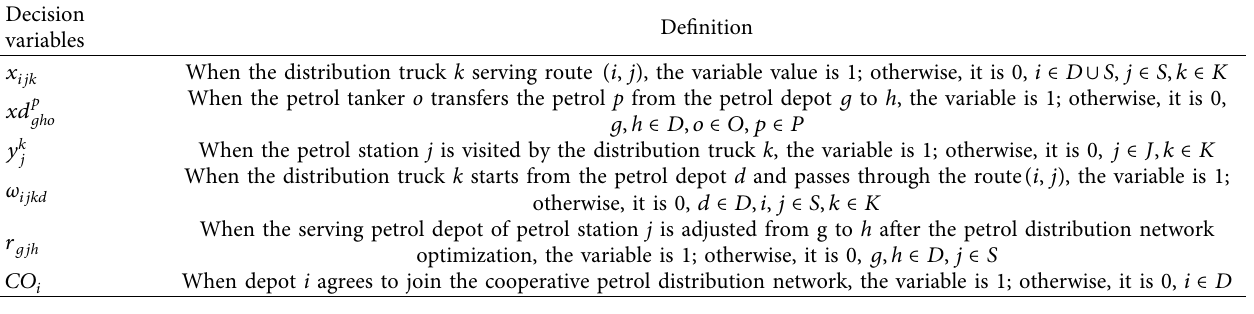
Table 3: Judgement